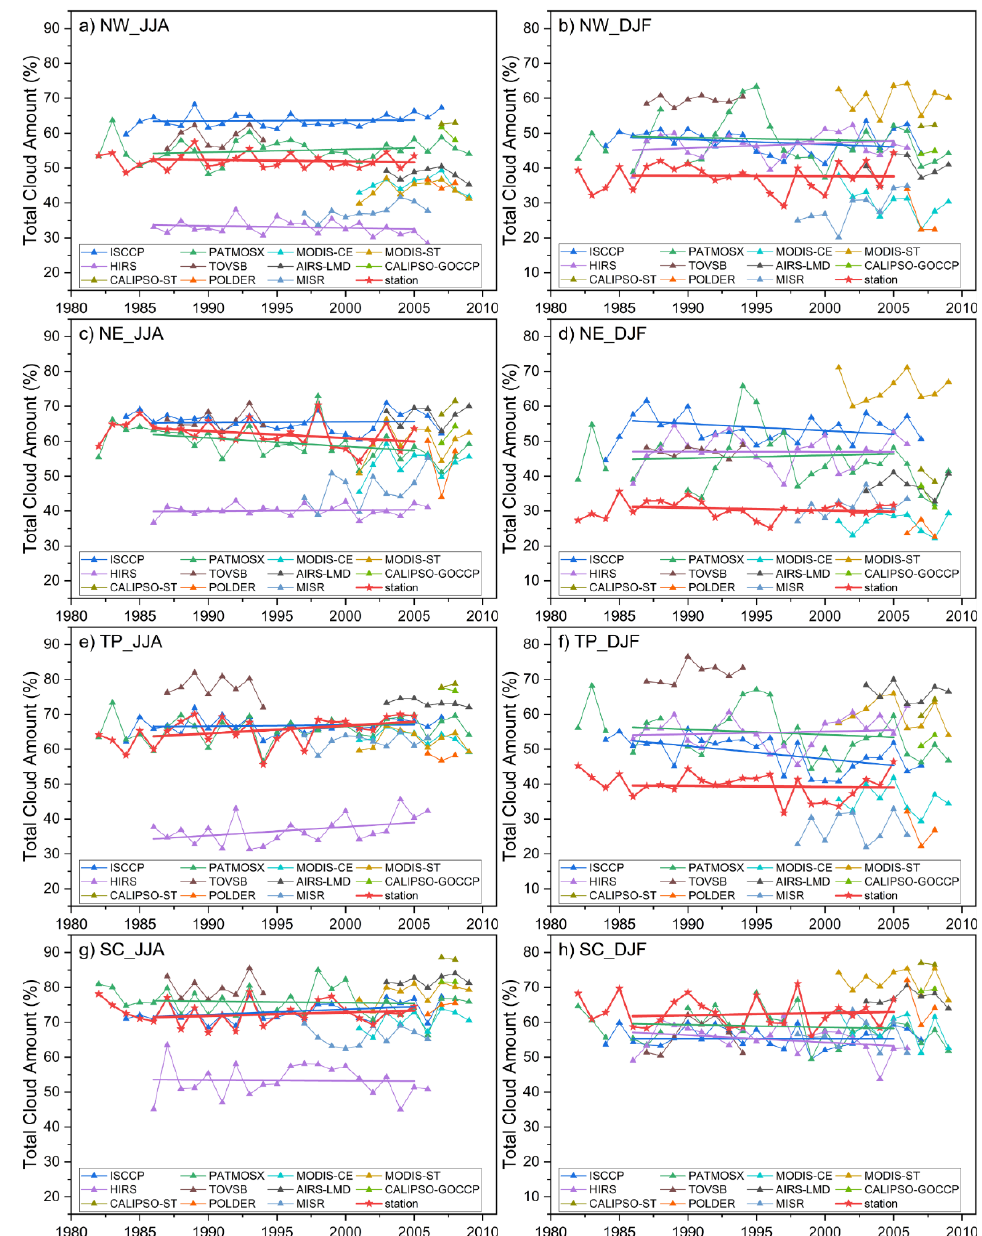
Figure 9. Interannual variation characteristics of the TCA in summer and winter in the different regions of China. ( a , b ) NW region; ( c , d ) NE region; ( e , f ) TP region; and ( g , h ) SC region. The red pentagram (red lines) represents site observations, and the other colored symbols represent results from different satellite datasets. The bold lines denote the linear regressions for the three satellites (HIRS, ISCCP, PATMOSTX) with more than 20-year observations available and for the station ob- servation.